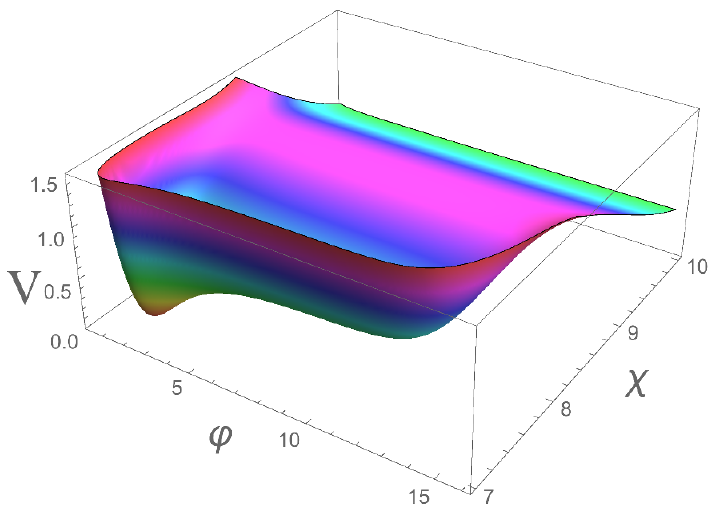
Figure 1 . The scalar potential V of the Fibre in(cid:13)ation. For ’ > 15, the potential in this model begins to rise, whereas at large (cid:31) the potential falls